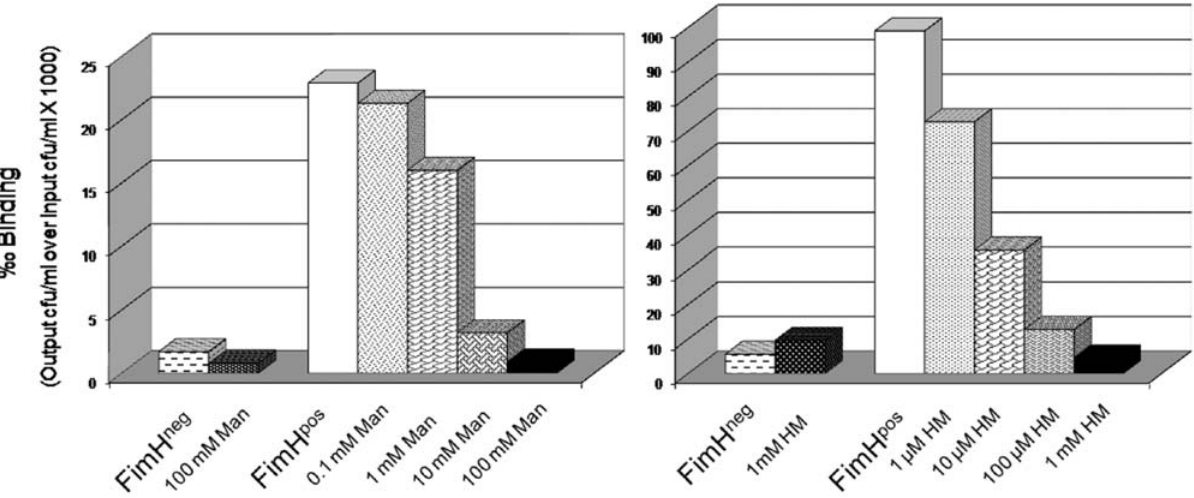
Figure 6. Inhibition of bacterial adhesion to 5637 bladder cells by mannose or heptyl a - D -mannose. Type 1 pili-expressing E. coli were incubated at 10 6 cfu/ml (FimH pos ) with the bladder cells, or had been mixed with a ten-fold dilution series of Man or HM prior to incubation, to compare inhibition of bacterial binding by the two sugars. An isogenic fimH -negative strain served as a negative control (FimH neg ).